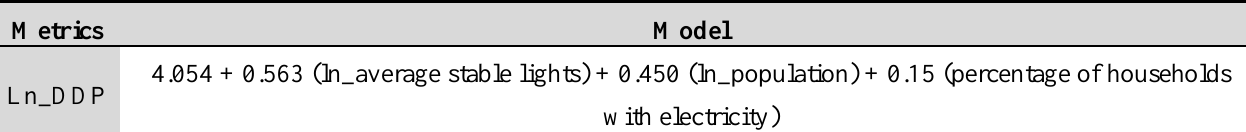
Table 5. Model to predict DDP.